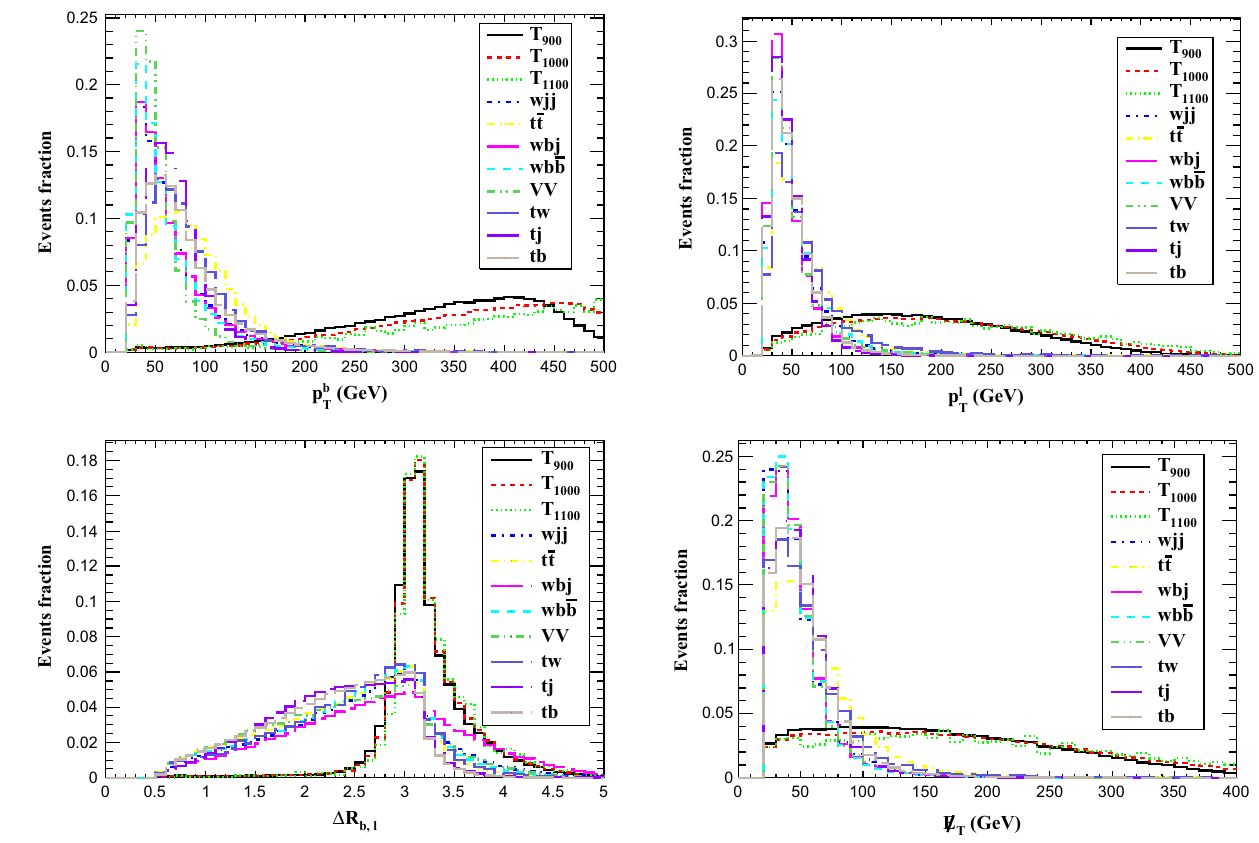
Fig. 4 Normalized distributions of the transverse momenta ( p b